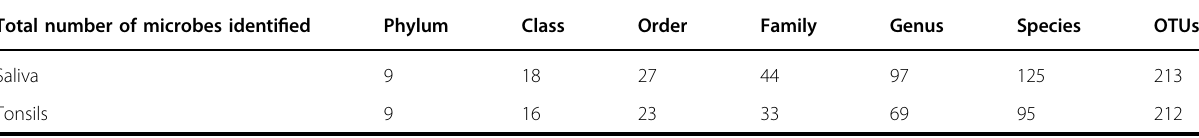
Table 2 Analysis of microbiomes of saliva and tonsillar